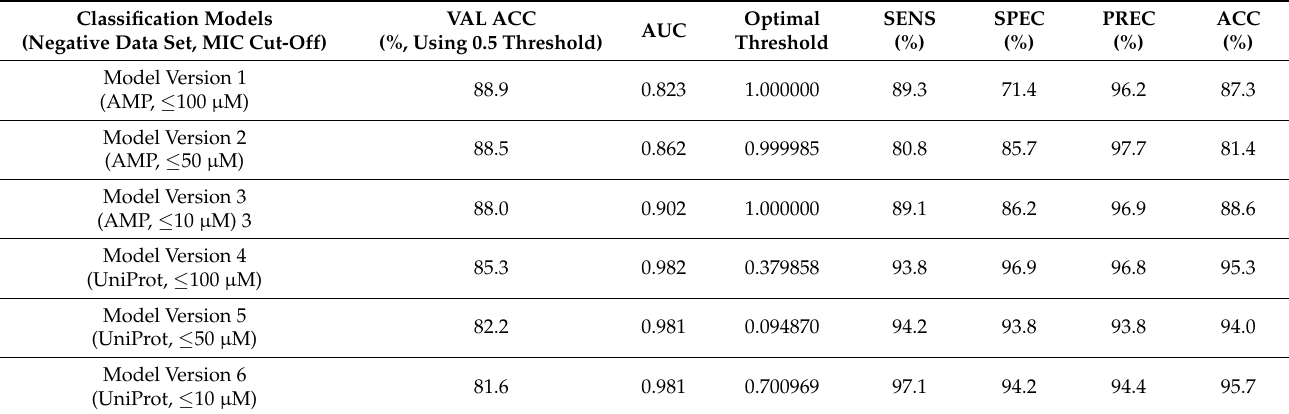
Note: ACC = accuracy, AMP = antimicrobial peptide, AUC = area under the curve, MIC = minimal inhibitory concentration, PREC = precision, SENS = sensitivity, SPEC = specificity, VAL ACC = validation